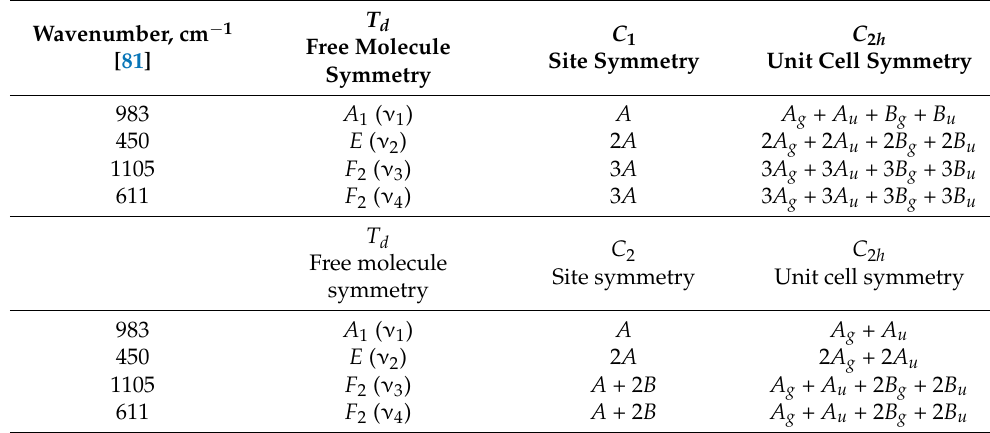
Table 3. Correlation scheme for the SO 42 − ion placed into the C 1 and C 2 symmetry positions of the unit cell having C 2 h